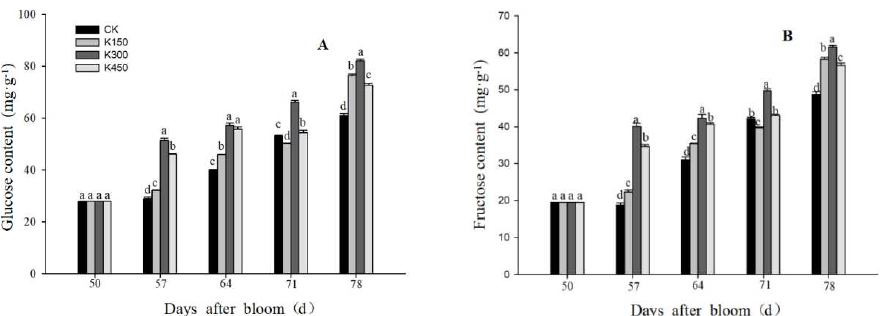
Figure 3. ( A ): Glucose content in flesh. ( B ): Fructose content in flesh. Different lowercase letters indicate significant differences among the treatments (Duncan’s Multiple Range Test, p < 0.05).